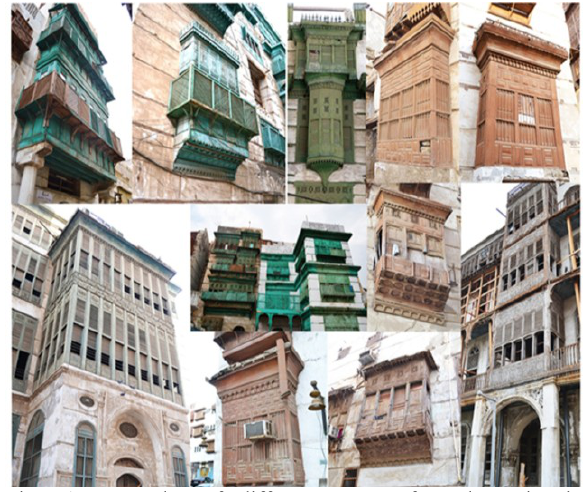
Figure1. Examples of different types of Roshans in the Historical City of Jeddah.